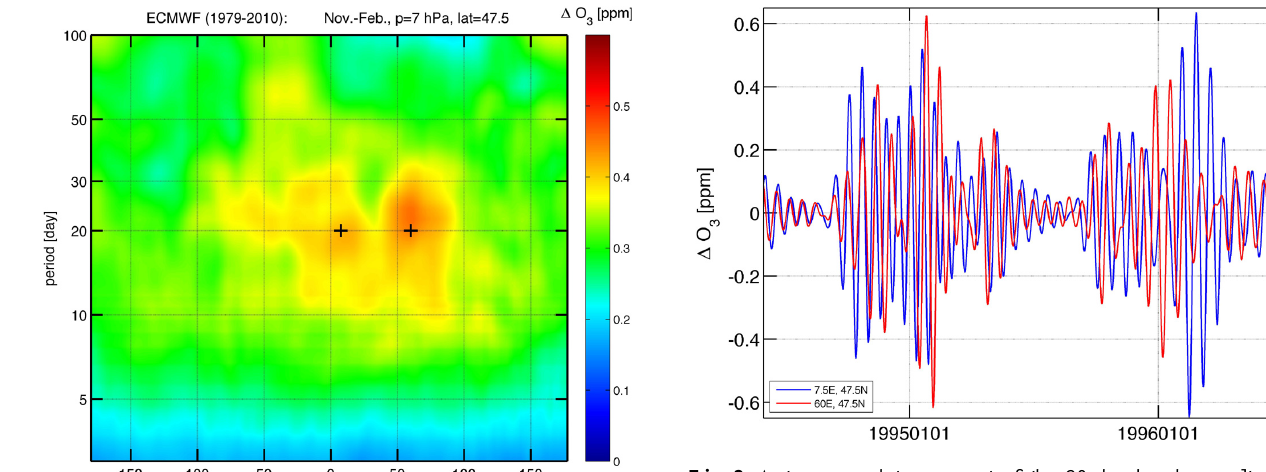
Fig. 3. A two-year data segment of the 20-day bandpass filtered ozone series at 7hPa is shown. The 20-day ozone oscillation at 7.5 ◦ E, 47.5 ◦ N (blue) clearly differs from that at 60 ◦ E, 47.5 ◦ N (red). A constant phase lock between the ozone oscillations at the two places does not exist. In addition there are intervals when the oscillation at 7.5 ◦ E, 47.5 ◦ N is strong and that at 60 ◦ E, 47.5 ◦ N is weak, e.g., end of winter 1995/1996. (The general increase of stratospheric ozone fluctuations during winter is well known and of no interest here.)